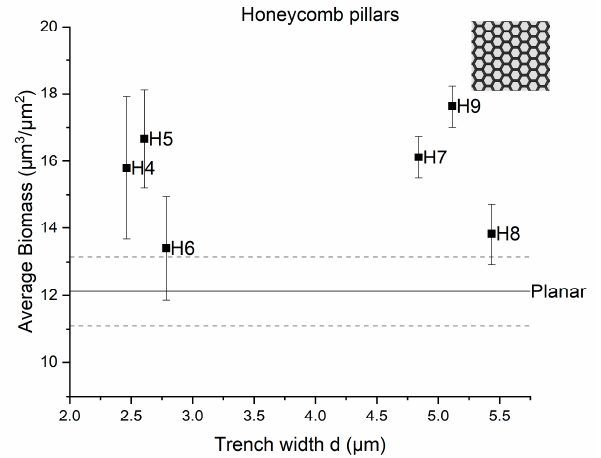
Figure 4. Average bacterial biofilm biomass ( µ m 3 µ m − 2 ) (bacterial volume/surface area) of Phaeobac- ter inhibens biofilm on the honeycomb pillar surfaces, as a function of trench width d . Data are depicted as mean + SD ( n = 3). The straight line serves as a baseline, as it indicates the average biomass on the planar surface, with the standard deviation for the planar surface shown with dashed lines.